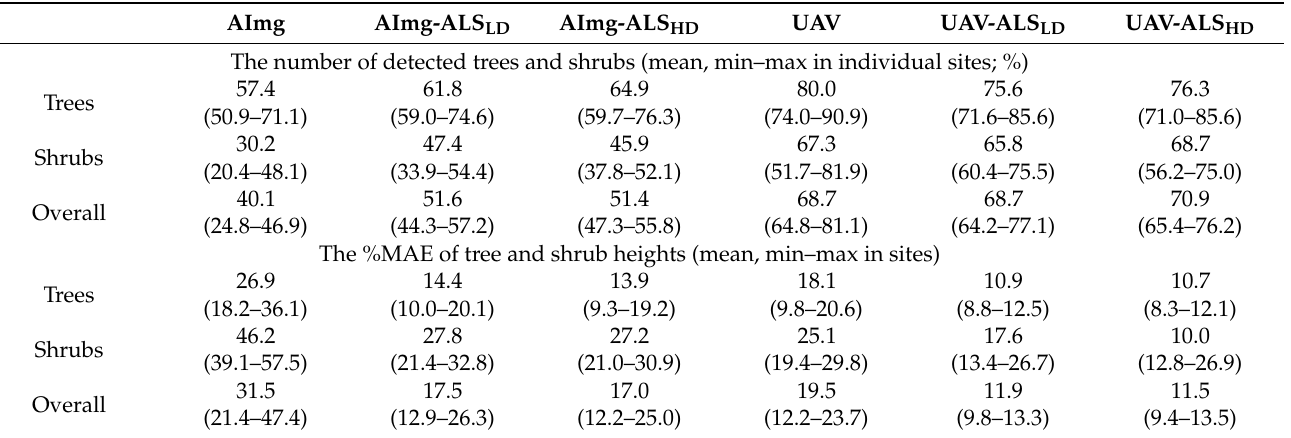
Table 6. The number of detected trees and shrubs (percentage of automatically correctly detected) and the height accuracy (percentage mean absolute error—%MAE) of trees, shrubs, and their combinations. Detected woody plants of 1–5 m were considered shrubs; those above 5 m were considered